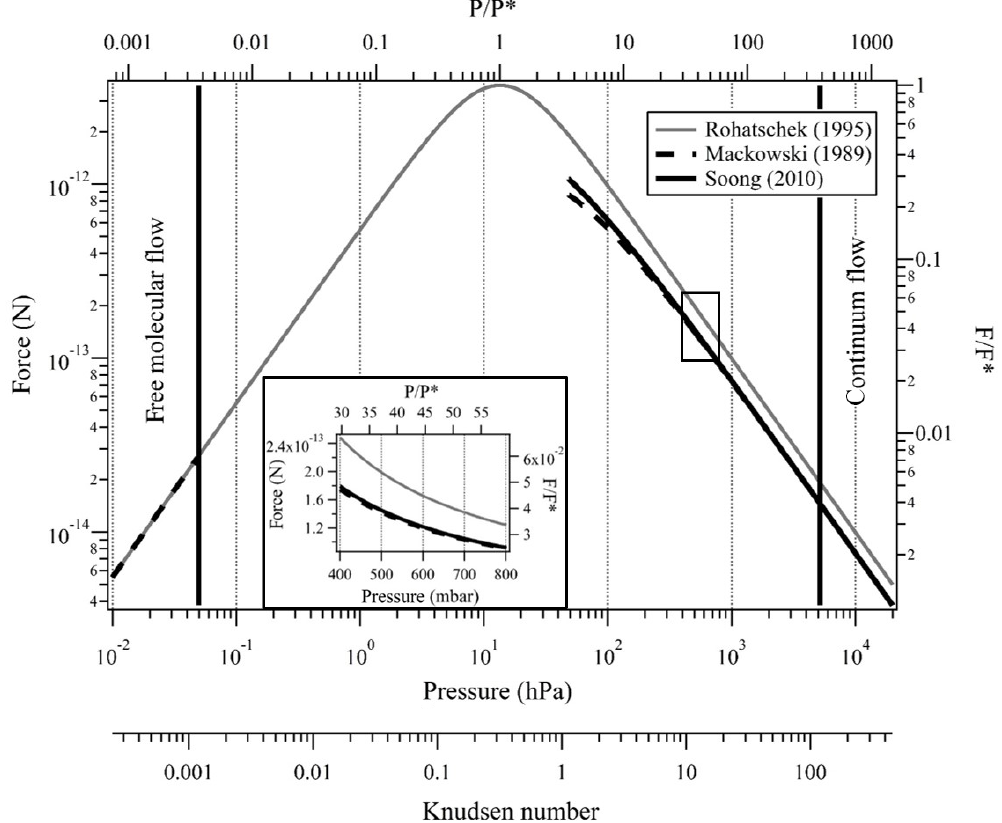
Figure 3. Indirect photophoretic force calculated with the Rohatschek (1995) approximation at the full pressure range (gray line), Mack- owski (1989) analytical solution (dashed line), and Soong et al. (2010) correction (solid line) for a slightly absorbing particle with radius of 10µm, T = 20 ◦ C, m = 1 . 466 + i 10 − 4 , λ = 473nm, I = 35mWmm − 2 and full thermal accommodation. The black rectangle and the insert plot show the pressure range that is possible with our experimental